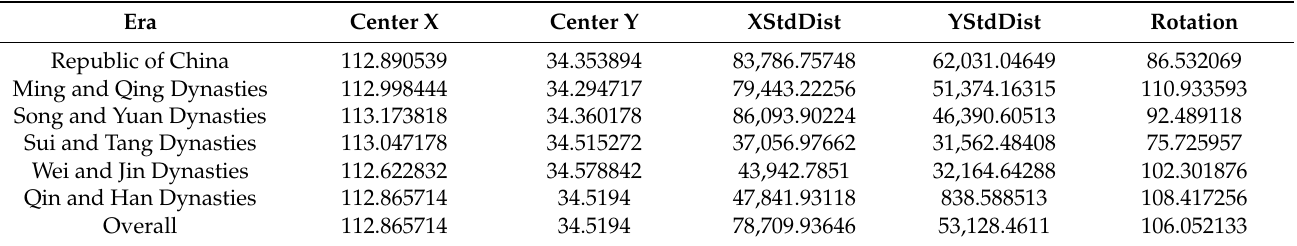
Table 3. Standard deviation ellipse index of the evolution of the distribution of historical buildings in different periods.